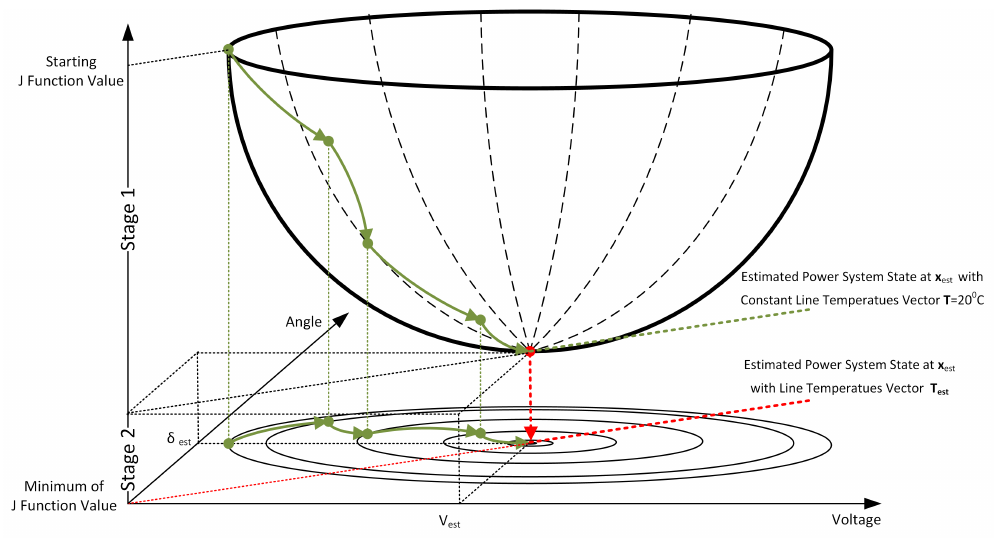
Figure 1. The idea of the two-stage method for power system state and line temperature estimation.